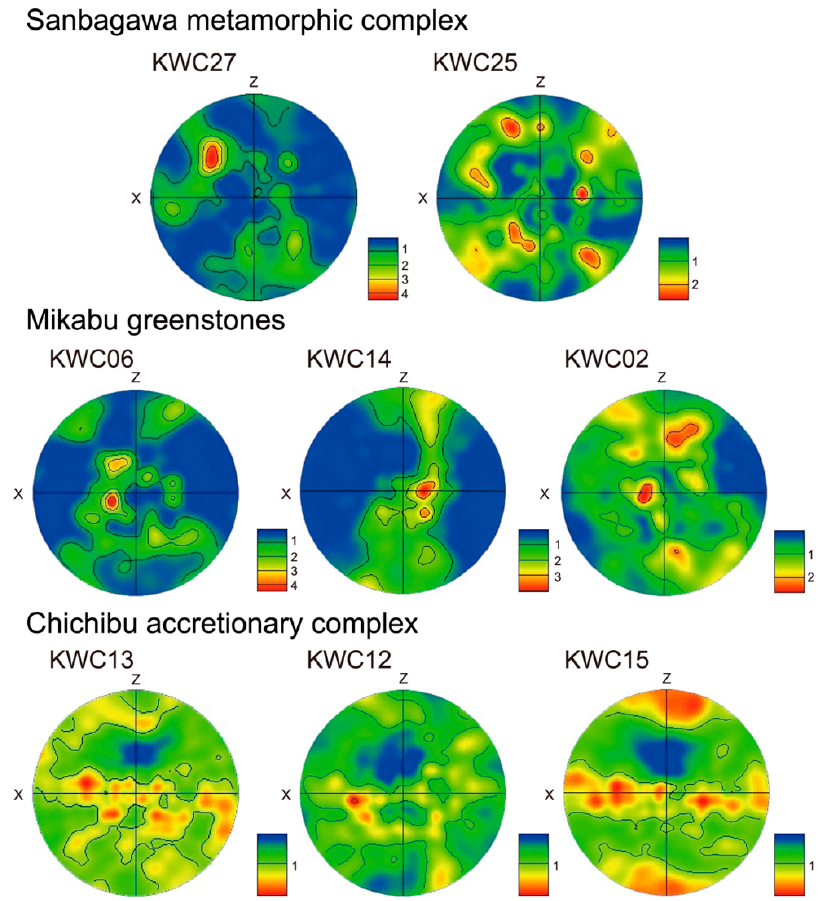
Figure 8. Contour diagrams of the quartz c -axis fabrics for the study samples (lower hemisphere equals the area projections). Color scale of pole figures indicates by the multiple of uniform distribution (mud).